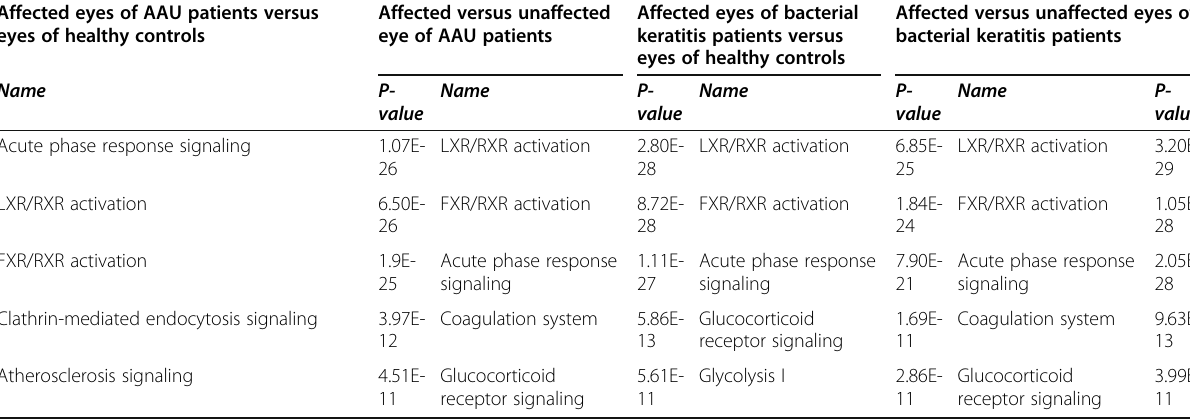
Table 3 Top canonical pathways Affected eyes of AAU patients versus eyes of healthy controls